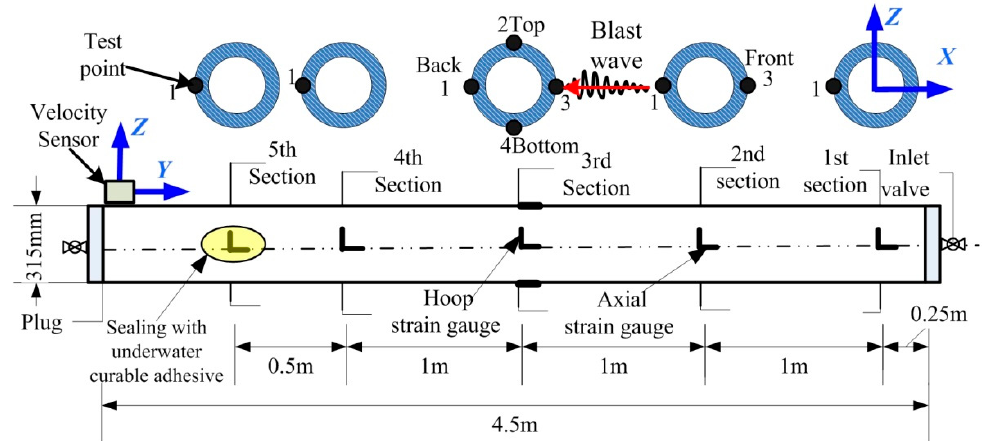
Figure 2. The layout of the strain gauges and velocity sensor.